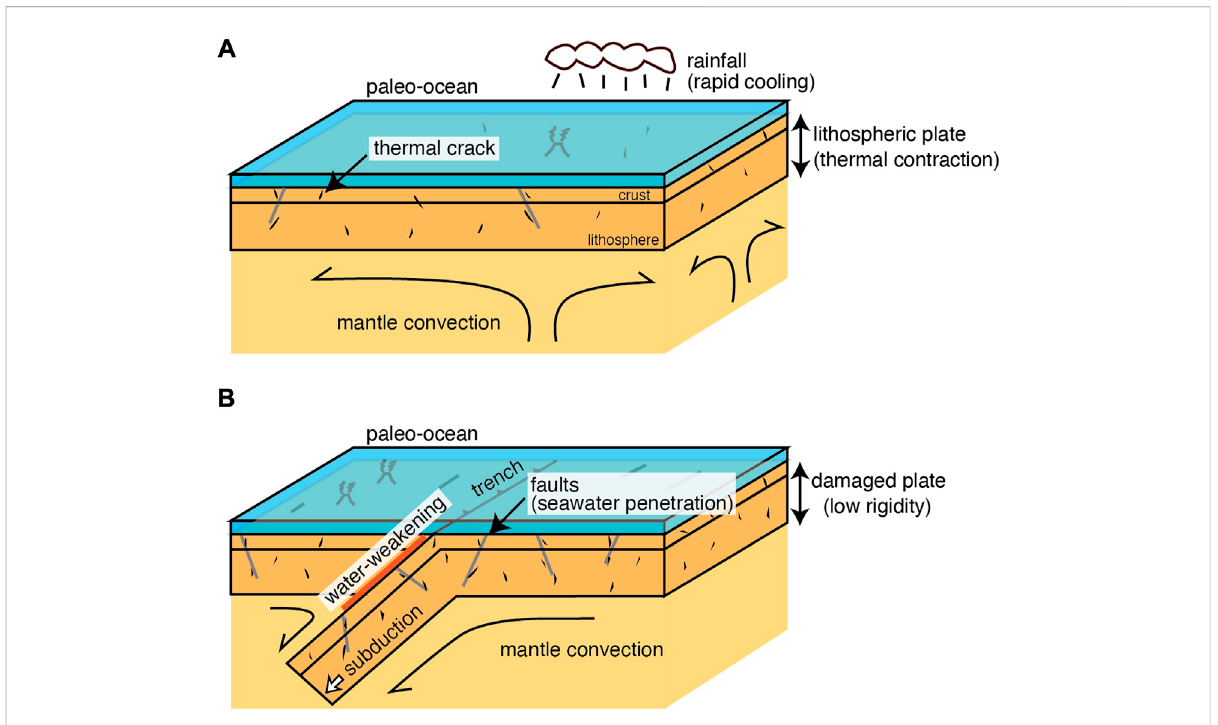
FIGURE 1 Schematic illustration of the initiation of plate tectonics. (A) , Effective cooling of the lithospheric plate results in the development of thermal cracks. (B) , Plate subduction can be triggered by water weakening due to penetration of seawater along fault zones and the low rigidity of the damaged